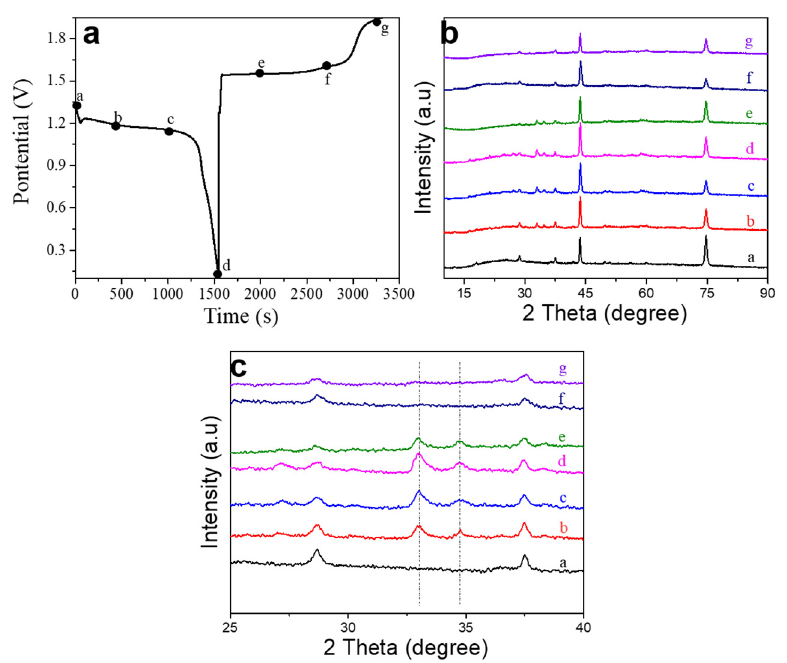
Figure 7. Electrode reaction mechanisms of MnO 2 -1 in ZIBs. ( a ) Charge/discharge curves of the MnO 2 -1 electrode; the dots in the figure indicate that samples at that charge/discharge depth were used for ex situ XRD analysis; ( b ) ex situ XRD patterns of the MnO 2 -1 electrode at various charge/discharge states; ( c ) magnified XRD patterns with 2 θ from 25° to 40°.